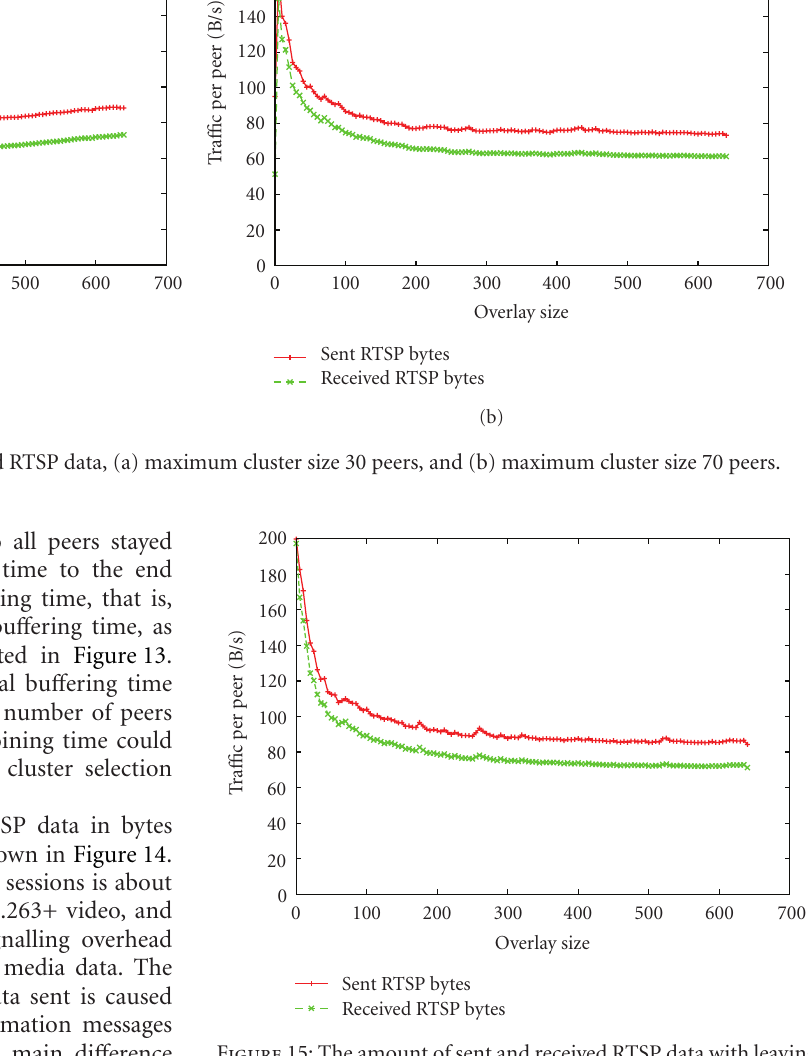
Figure 15: The amount of sent and received RTSP data with leaving and rejoining peers; maximum cluster size 70